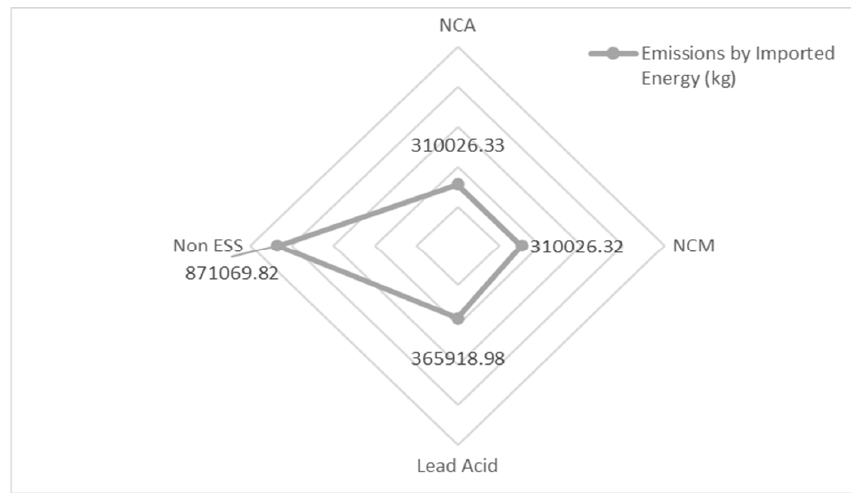
Energies 2021 , 14 , x FOR PEER REVIEW Figure 2. Total emissions by energy imported to the micro-grid (kg). Figure 2. Total emissions by energy imported to the micro-grid (kg).